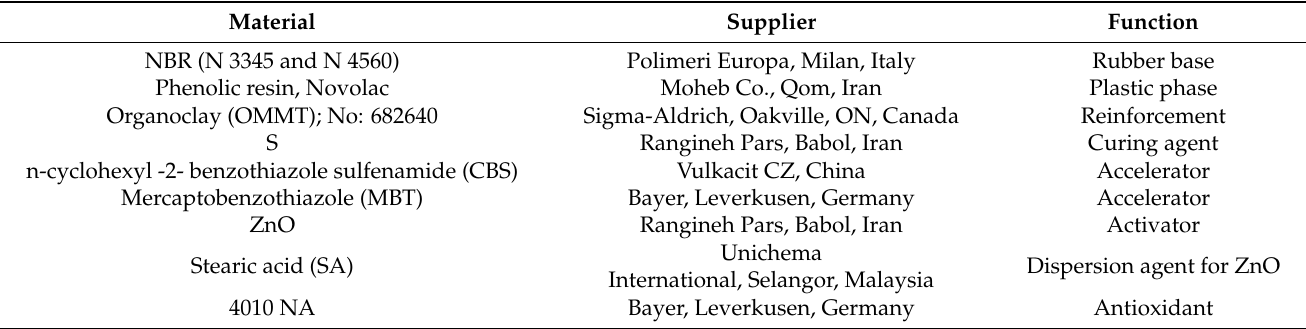
Table 1. Materials used for the preparation of the samples.